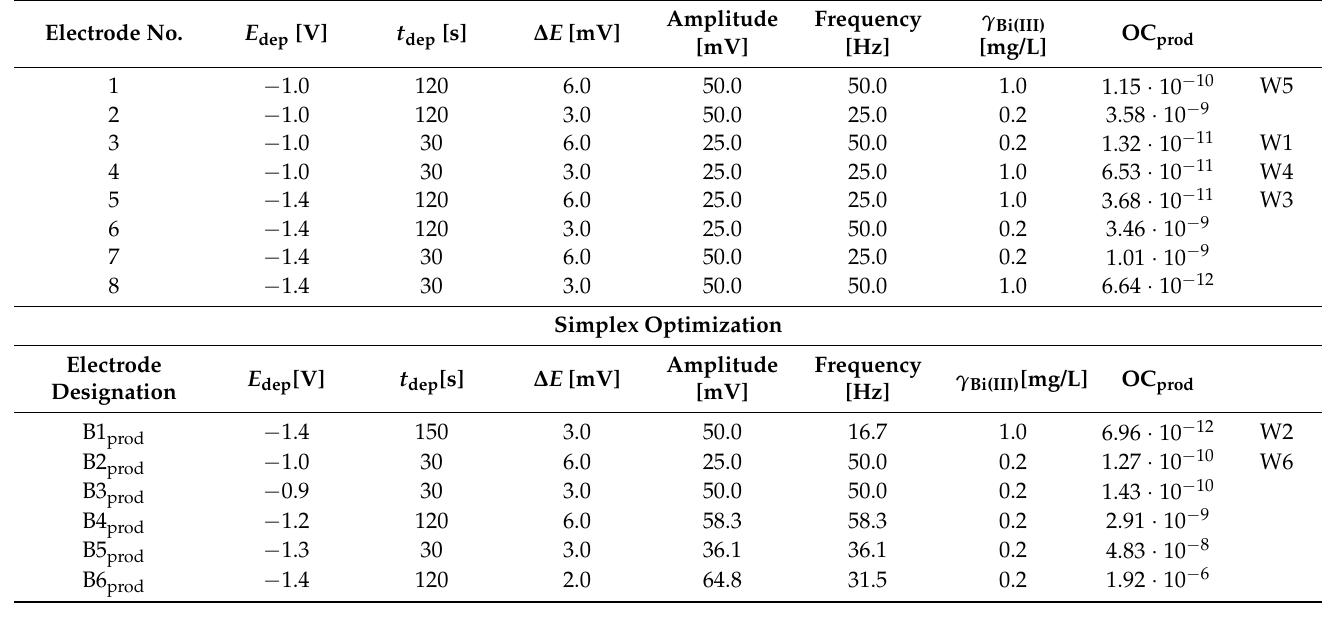
Table 4. The simplex optimization procedure with designated Wi and Bi, when OC prod is taken as the